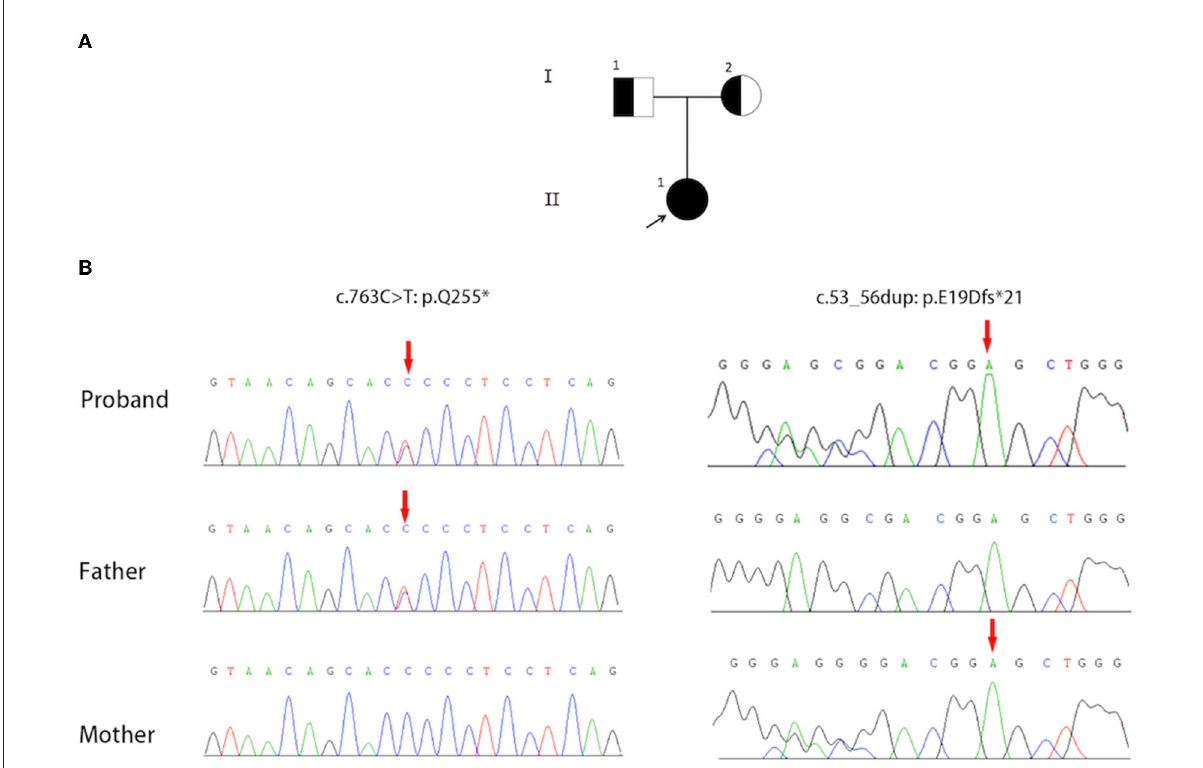
FIGURE5 (A) The pedigree contains three family members and two generations of Hermansky-Pudlak syndrome type 2 (HPS-2) (I1, I2, II1). The square represents the male, and the circle represents the female. The filled circle (arrow) represents the proband. A half-filled square or circle represents the carrier. (B) Sequence Chromatograms show the compound heterozygous mutations (c.763C > T: p.Q255 * ) and (c.53_56dup: p.E19Dfs * 21) in the AP3B1